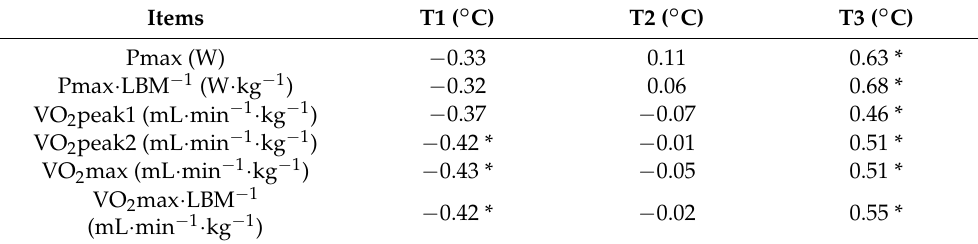
Table 3. Pearson correlation between thermal parameters and baseline measurements of physical